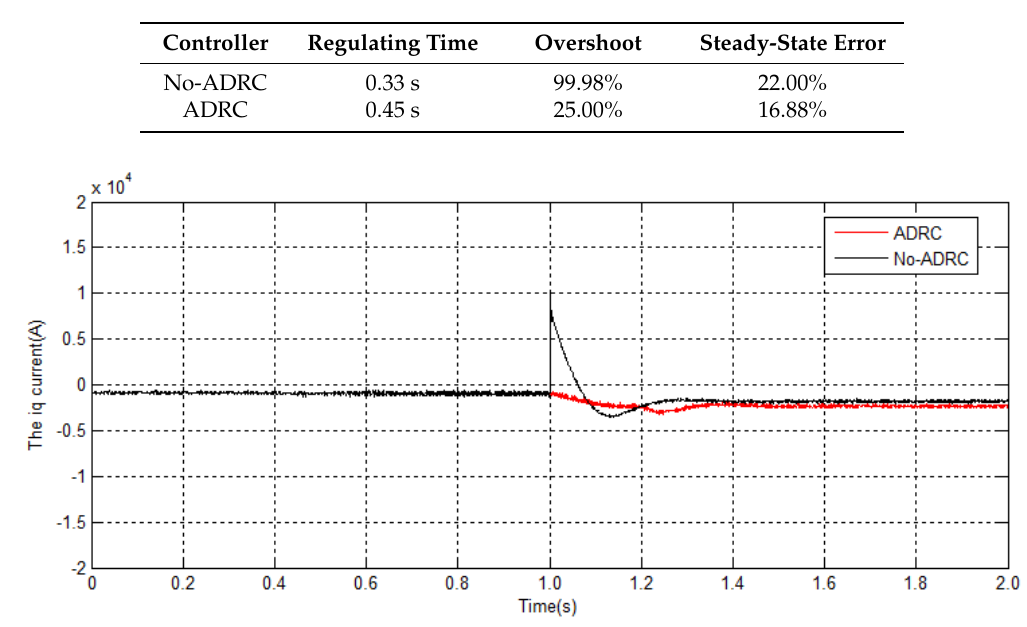
Figure 16. Simulation curve of the q -axis current.